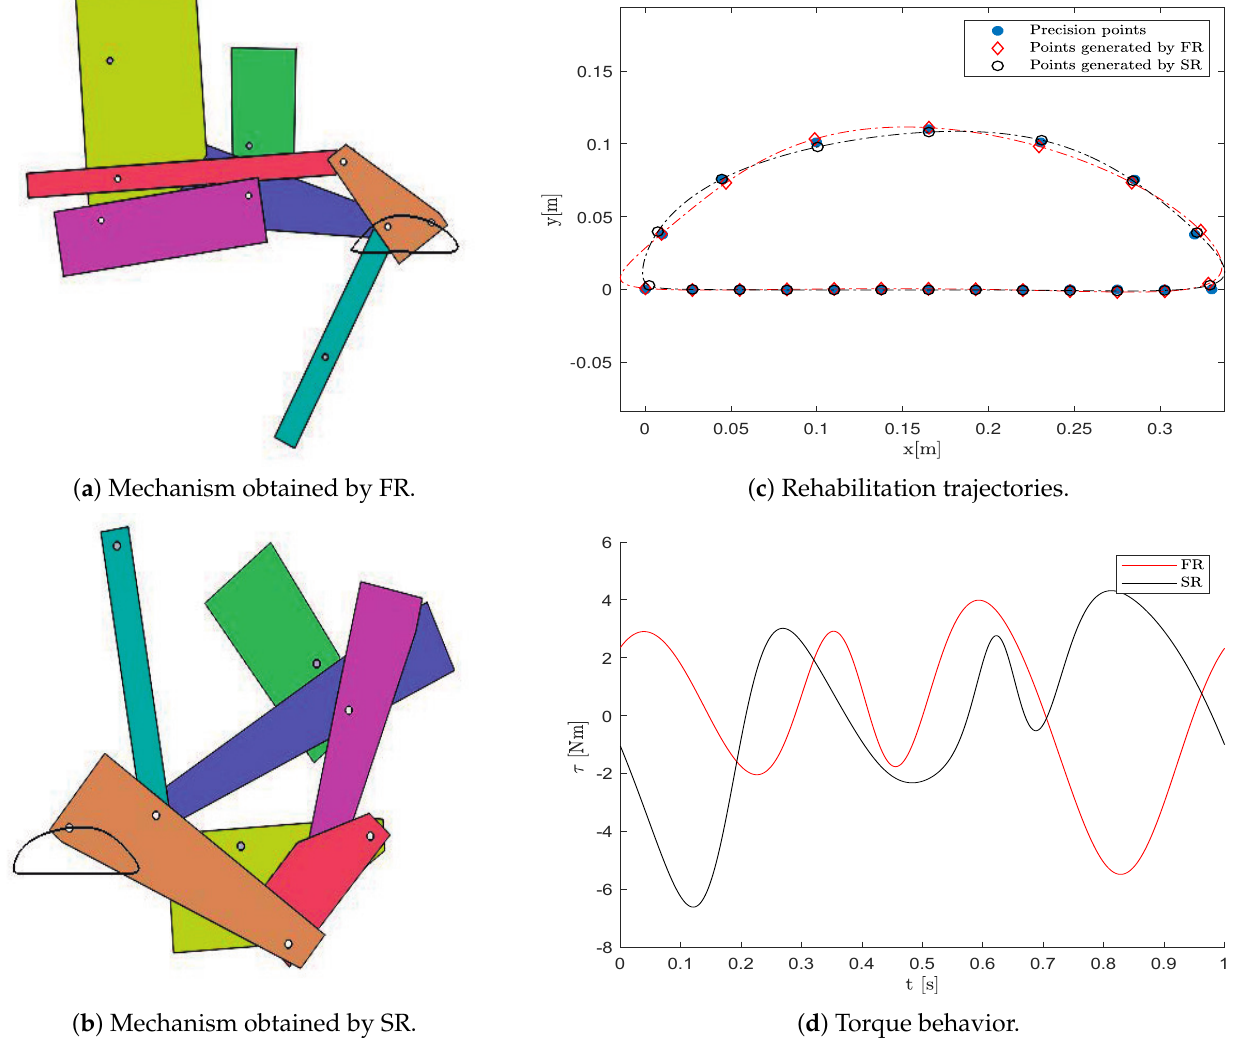
Figure 10. CAD representation and trajectory generated of the mechanism (related to the design goals) given by the best and the worst constraint-handling technique for solving study case